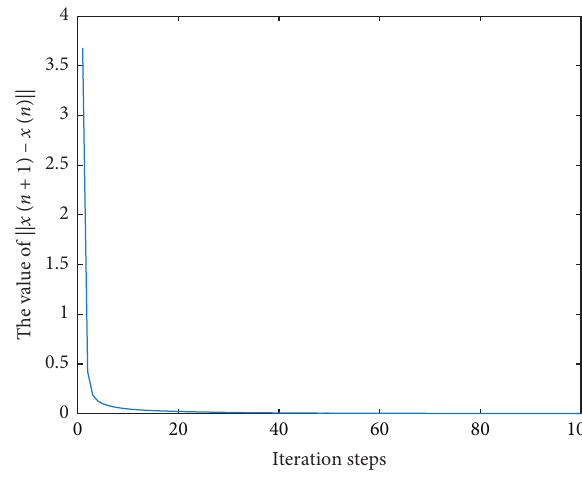
Figure 8: The iterative curves of algorithm (21) under different n